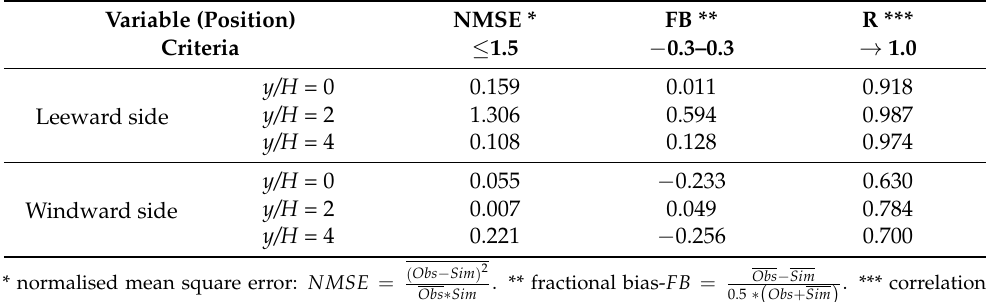
Figure A3. Validation for the vegetation modelling. ( a ) Configurations of the wind tunnel experiment with vegetation model. ( b ) Vertical profiles of K at the leeward wall. ( c ) Vertical profiles of K at the windward wall. Table A4. Statistical analysis between wind tunnel data and CFD simulation results—vegetation